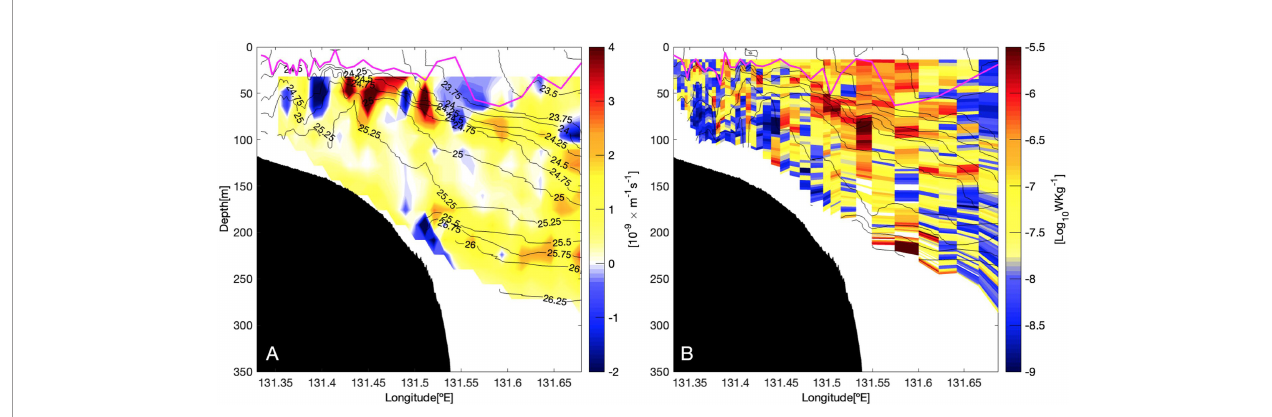
FIGURE 5 | Observations taken onboard in November 2018 (Nagai et al., 2019) for (A) two-dimensional potential vorticity (1) and (B) turbulent kinetic energy (TKE) dissipation rate (WKg -1 ). The black contours represent isopycnals and the magenta line represents the